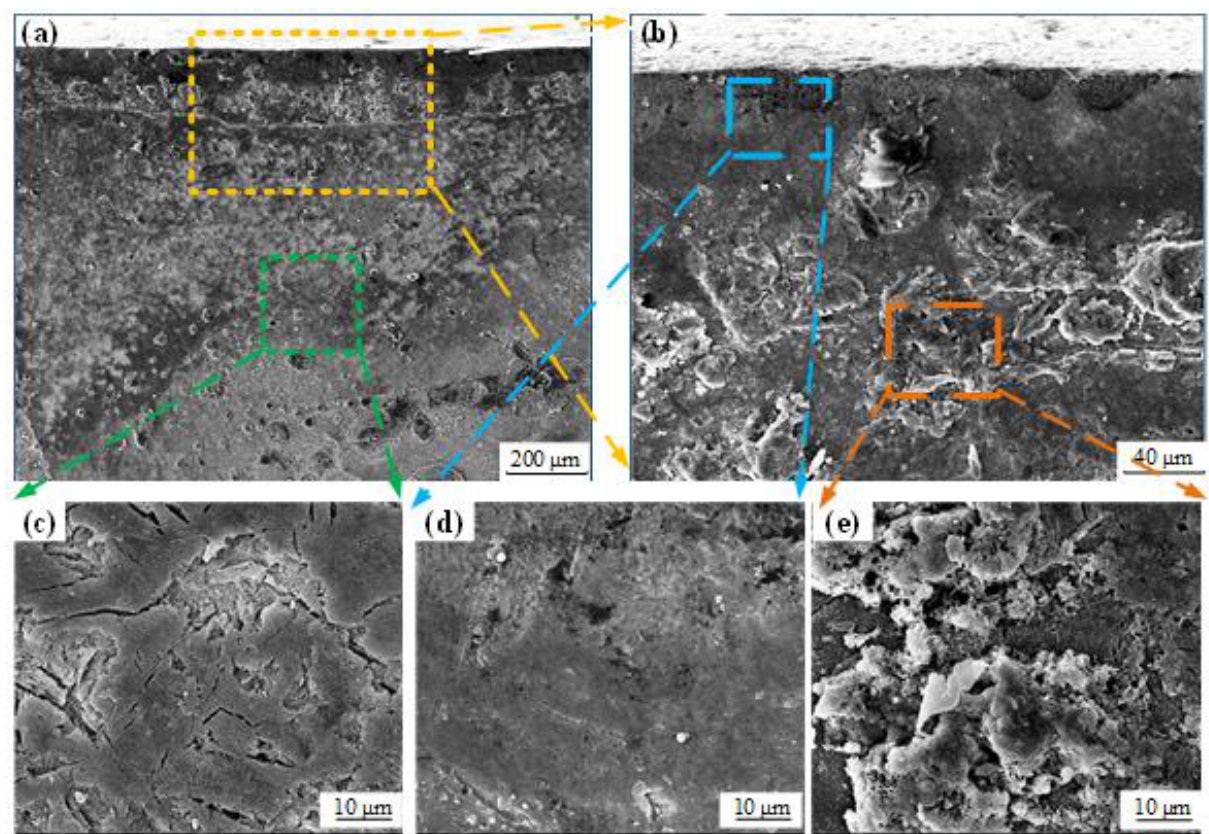
Figure 11. ( a , b ) Polarization corrosion morphologies of sample cross section and detail views of ( c ) substrate, ( d ) surface layer, and ( e ) subsurface layer.